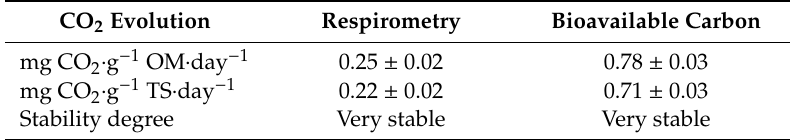
Table 3. Stability indicators for the compost product in pile 1 .